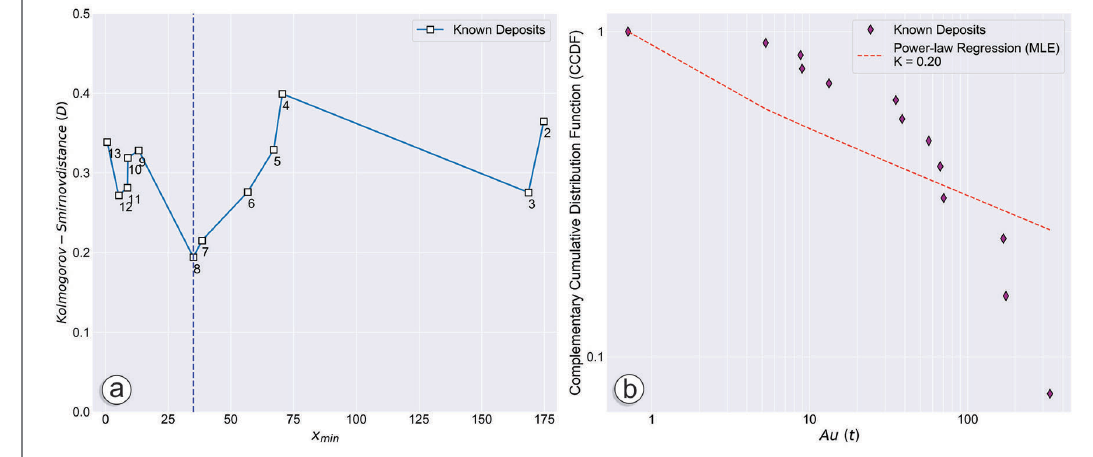
FIGURE 3 - a) Kolmogorov-Smirnov’s distance for the known deposits of Quadrilátero Ferrífero. The minimum of the function (dashed vertical blue line) stands at rank 8 (or x =35.08). b) The log-log plot between the Complementary Cumulative Distribution Function (CCDF) and the min gold deposits. The dashed red line shows the power-law regression using the Maximum Likelihood Estimator (MLE) with k = 0.89.